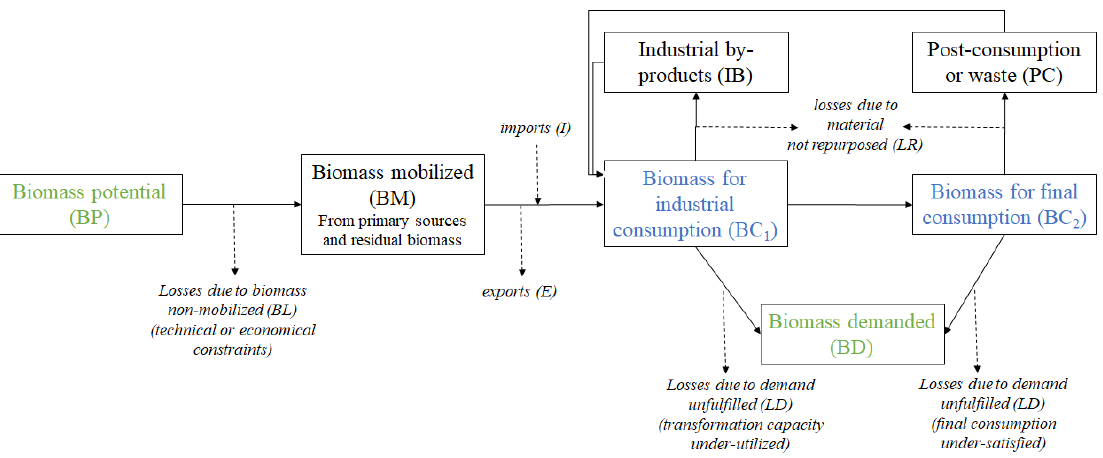
Figure 3. Characterization of the wood-based biomass flows.